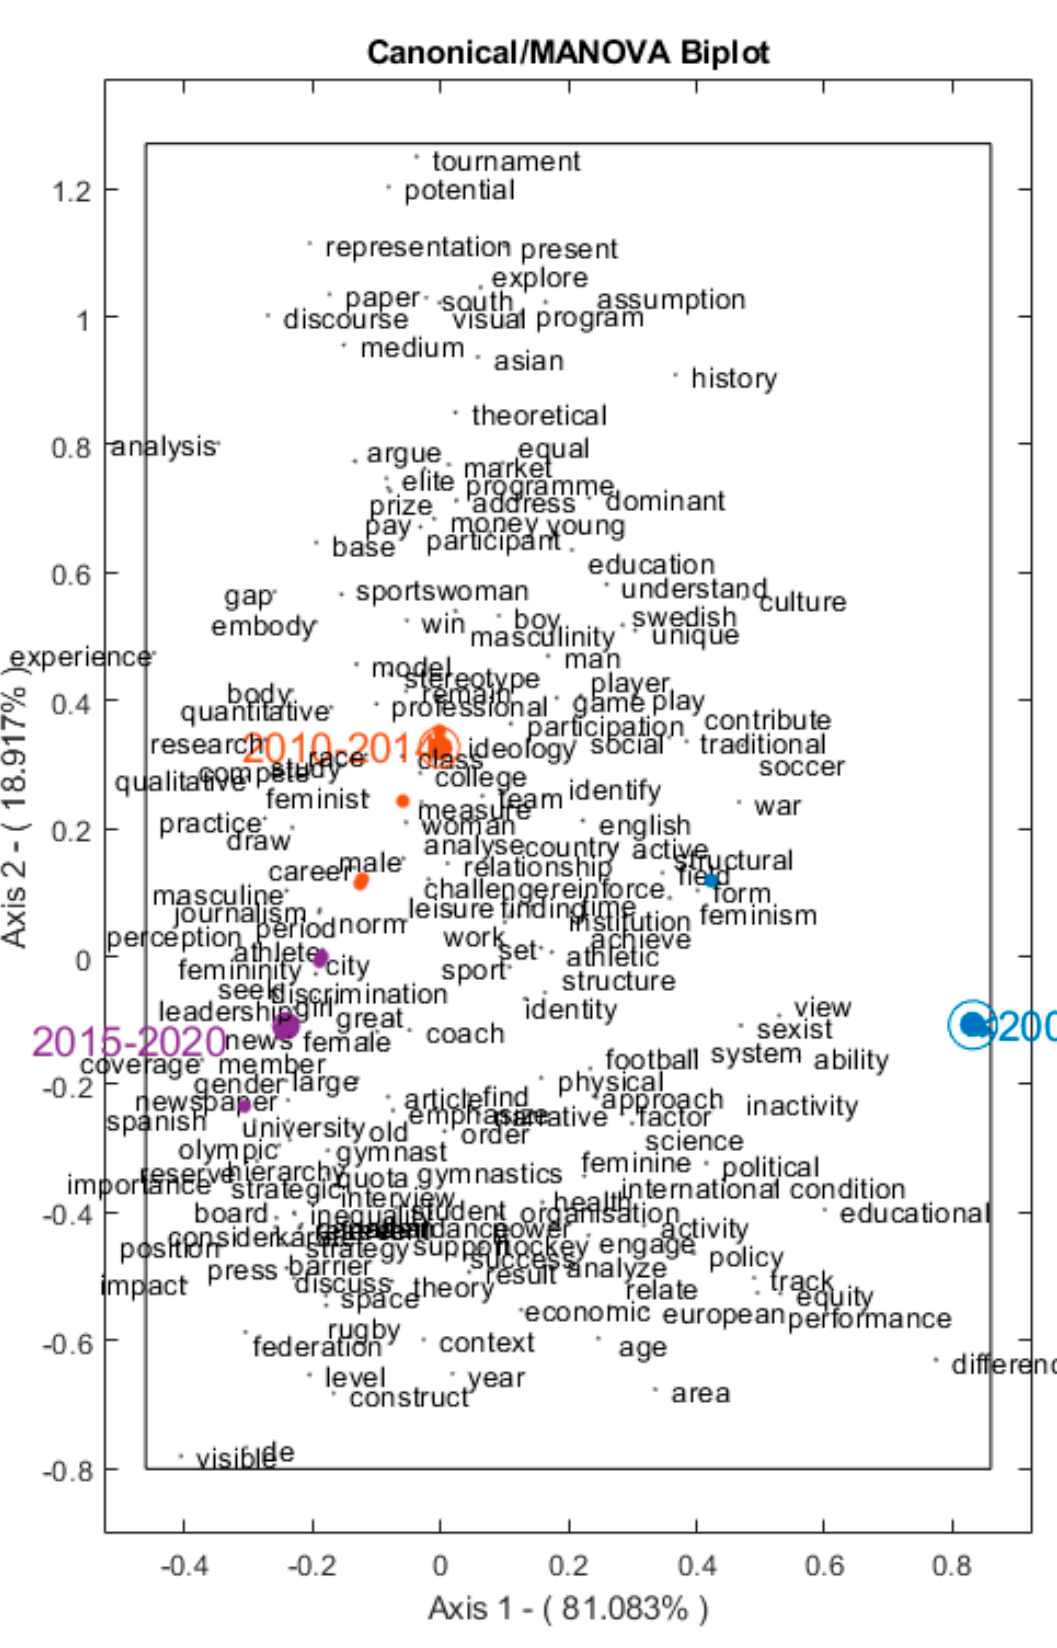
. Figure 5. Manova Biplot without vectors for the SLR of inequalities in women’s Figure 5. Manova Biplot without vectors for the SLR of inequalities in women’s sport. The words which characterize this group and which point towards the fourth quad- rant are, among others: “view”, “sexist”, “system”, “ability”, “inactivity”, “political”, “condition”, “educational”, “difference”. From 2010, the interest of researchers in inequal- ities in women’s sport will turn to the analyses of the dominant representations and dis- courses in sport, a theme that can be reconstructed from words that have strong positive correlations with the positive values of the second canonical variable of the MANOVA Biplot (first and second quadrants). These words are, for example, turning, potential, rep- resentation, present, discourse, dominant. In this sense, we can consider that the literature dedicated to the study of women’s sport seems to have shifted from a macro-analytical perspective to a more micro-analytical one, where qualitative and quantitative studies are more focused on discourse and representations. More recently, since 2015, the character- istic vocabulary of the articles selected is clearly differentiated from the other two, by aligning with the first axis but by opposing the group of publications released before 2009. This is a sub-corpus of publications on much more targeted aspects of gender inequalities